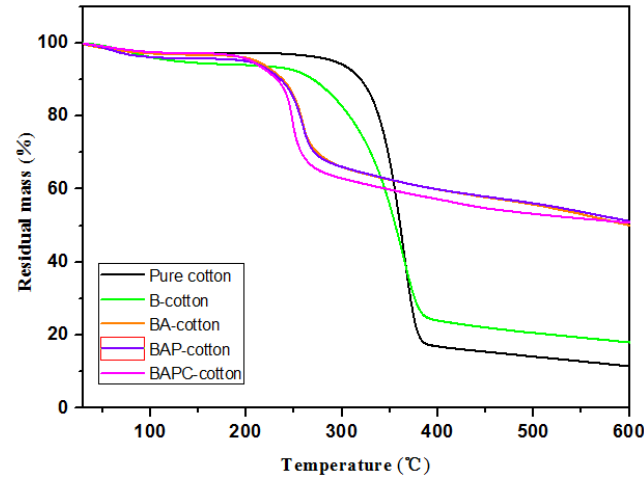
Figure 3. TGA curves of the pure, B, BA, BAP and BAPC cotton fabric.